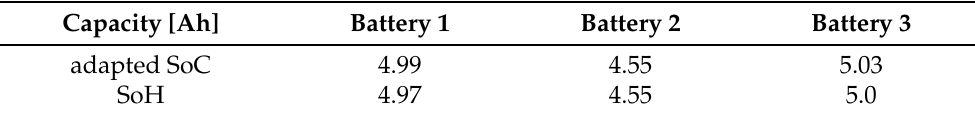
Table 18. Remaining Capacity at the end of the month of simulation: